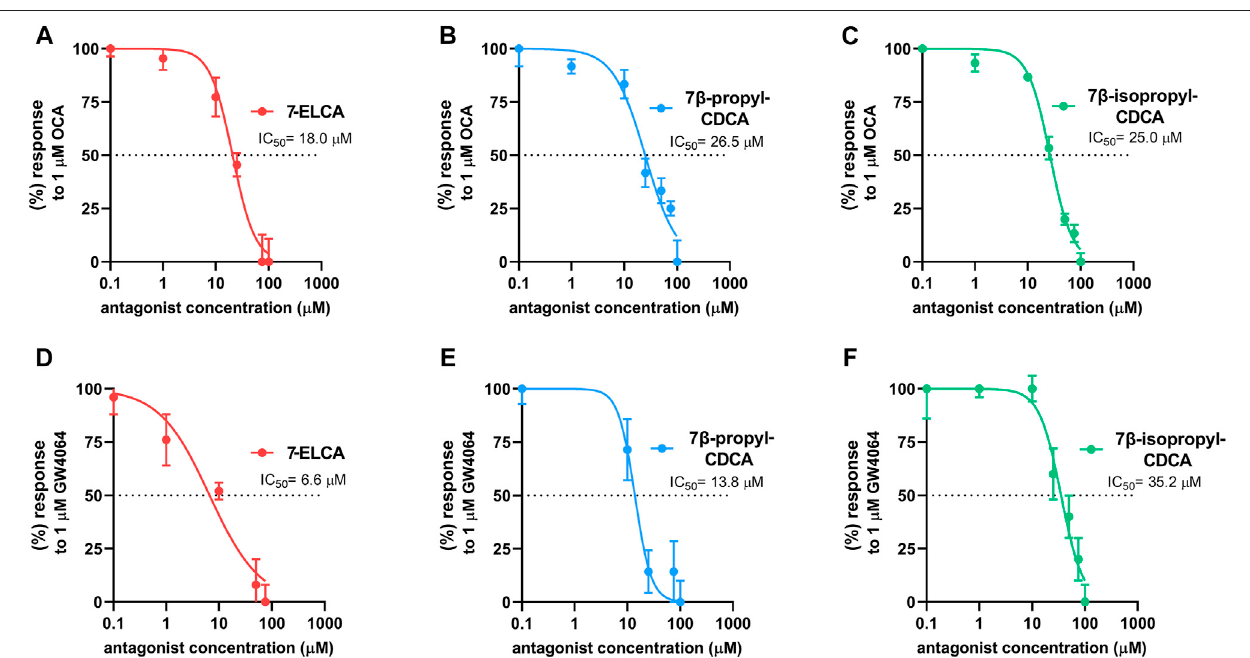
FIGURE 5 | 7-ELCA, 7 β -propyl-CDCA and 7 β -isopropyl-CDCA inhibit, in a concentration-dependent manner, the interaction of the FXR LBD stimulated by OCA (1 μ M, (A – C) or GW4064 (1 μ M, (D – F) with SRC-2 co-activator peptide in the TR-FRET FXR Coactivator assay. IC 50 values were calculated from three independent experiments performed in four replicates using concentration-response curves nonlinear fi tting (log(inhibitor) vs. normalized response) in GraphPad software.